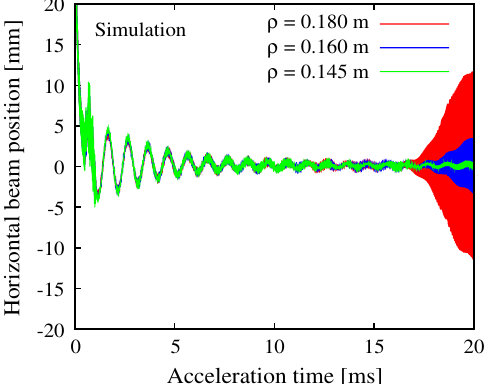
FIG. 17. Estimated Δ ν as a function of time for three coh different vacuum chamber radii for a beam power of 0.375 MW. The synchrotron tune ν s is also shown by the black line. The injection and extraction energies are 0.181 and 3 GeV, respectively.